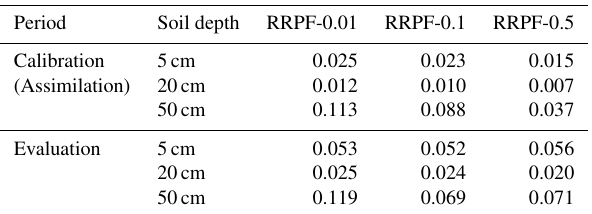
Table 7. RMSE values of VIC-3L for the Rollesbroich soil mois- ture observations at 5, 20, and 50cm depths using data assimilation with RRPF during the calibration period. We also summarize the subsequent performance of the VIC-3L model using the calibrated parameter values and initial states derived from RRPF. The sub- scripts 0.01, 0.1, and 0.5 signify the value of the scaling factor s of the multivariate normal distribution that is used to perturb the parameter values (importance